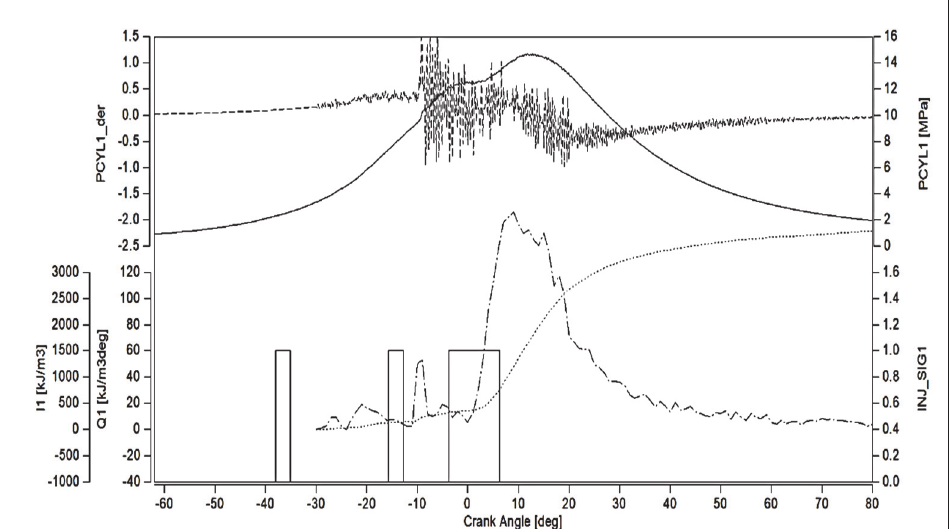
Figure 10. The waveform of the main injection and combustion parameters (MOD2), i.e. , the rate of heat of combustion (Q1), the amount of heat of combustion (L1), the combustion pressure (PCYL1), the rate of combustion pressure build ‐ up (PCYL1_der) and the injector control signal (INJ_SIG1) — under the established engine operating conditions, engine speed 2000 [rpm] and load 130 [Nm].